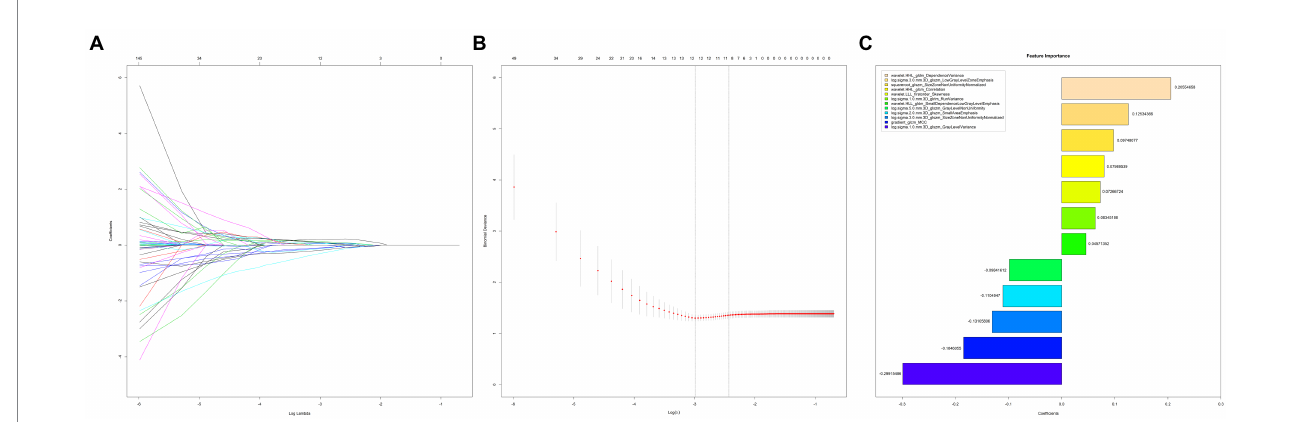
FIGURE 1 Radiomic features selection using the LASSO logistic regression model. (A) LASSO coefficient profiles of the 157 radiomics features. The coefficients (y-axis) were plotted against log (lambda), and the radiomics signature was constructed utilizing the selected 12 radiomic features with non-zero coefficients; (B) . Plotting the partial likelihood deviance against log (lambda). The upper and lower x-axis indicate the average number of predictors and the log (lambda), respectively. The y-axis denotes the partial likelihood of deviance. Utilizing the minimum criteria and one standard error of the minimum criteria, vertical lines (dotted) were created at the optimal values. The minimum criteria-based 10-fold cross-validation was utilized for the selection of the tuning parameter ( λ ) in the LASSO model; (C) . Feature importance analysis based on LASSO